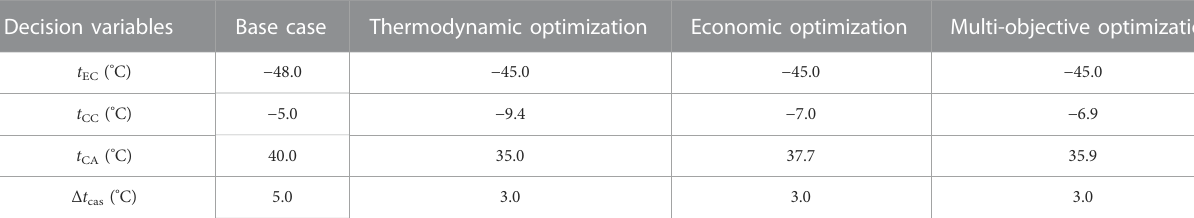
TABLE 6 Decision variables.